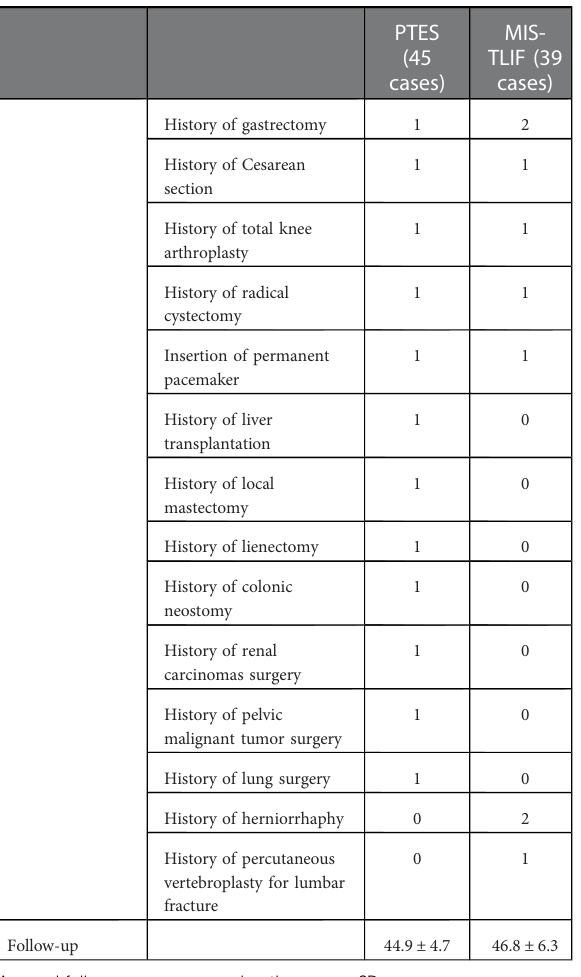
TABLE 1 Characteristics of the